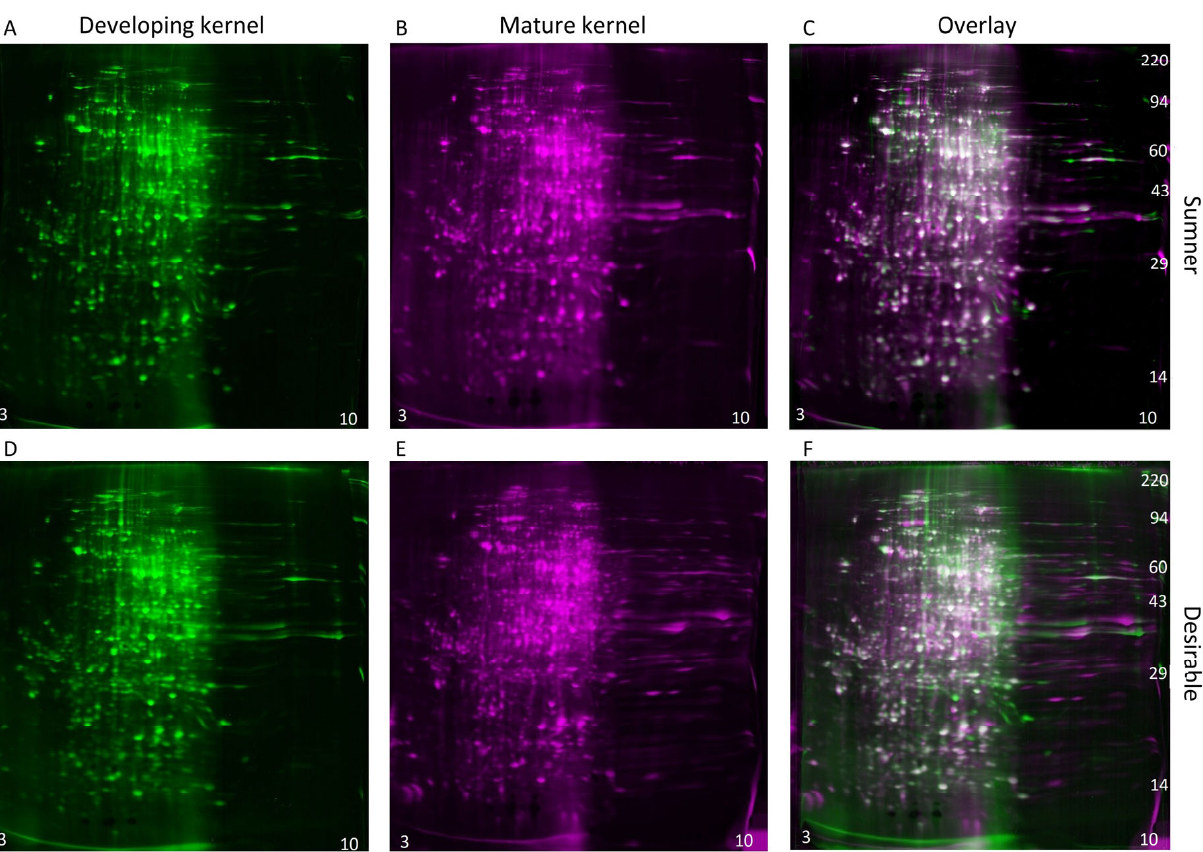
Figure 6. Comparison of the developmental time points within cultivars by two ‐ dimensional gel electrophoresis and silver staining. ( A – C ) Sumner pecan nuts. ( D – F ) Desirable pecan nuts. ( A , D ) Protein extract from developing (9/18) pecan nuts shown in green coloration. ( B , E ) Protein extract from mature (9/25) pecan nut shown in magenta coloration. ( C , F ) Overlay of 2 ‐ D gel analysis of the proteins of developing vs. mature pecan nuts. Silver ‐ stained spots appear white when equally abundant in both gels. Relatively acidic proteins (pH 3) accumulate to the left and relatively basic proteins (pH 10) accumulate to the right of each gel, and molecular weight markers are indicated on the right ‐ most panel of each montage.